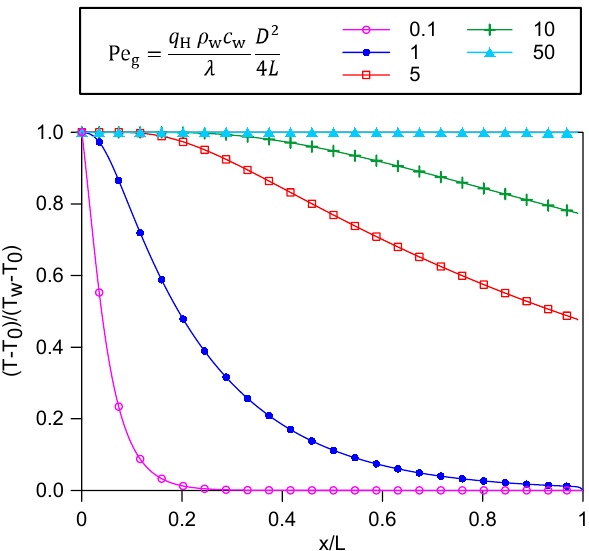
Figure 14. Temperature distribution along the seepage path as a function of the geothermal Péclet number for the sand layer in Fig. 12. Results of a finite element parametric study in steady-state